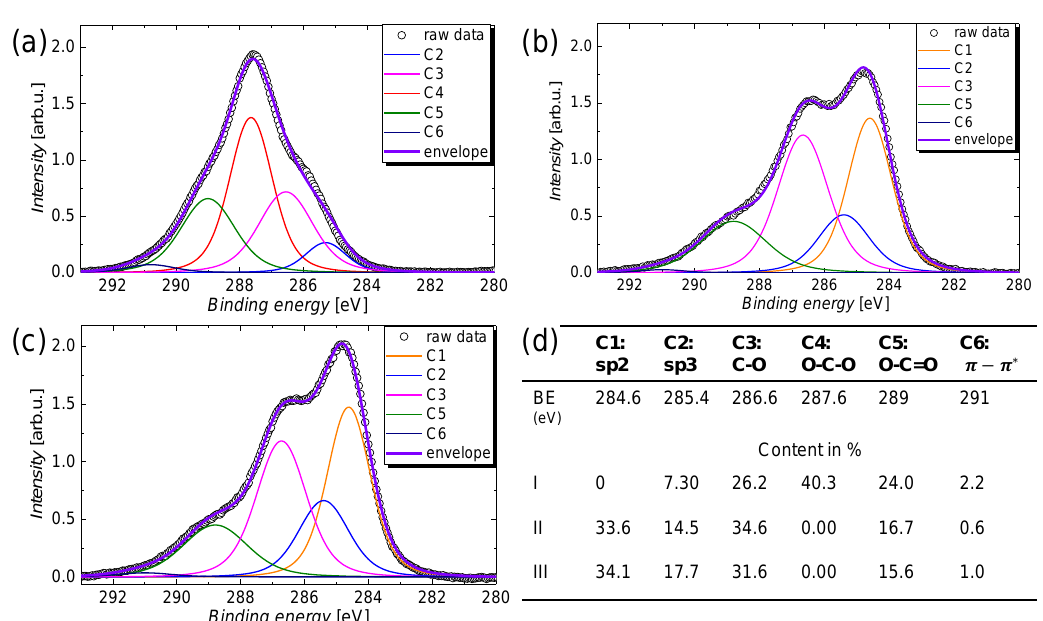
Figure 3. High resolution C 1s XPS spectra for the CMC-CNT films that were subjected to different treatments: ( a ) I, ( b ) II, and ( c ) III. The raw spectra were decomposed into different contributions by Lorentzian fits. ( d ) Table that summarizes the different contributions of carbon-containing species that add up to the spectra ( a – c ). BE—binding